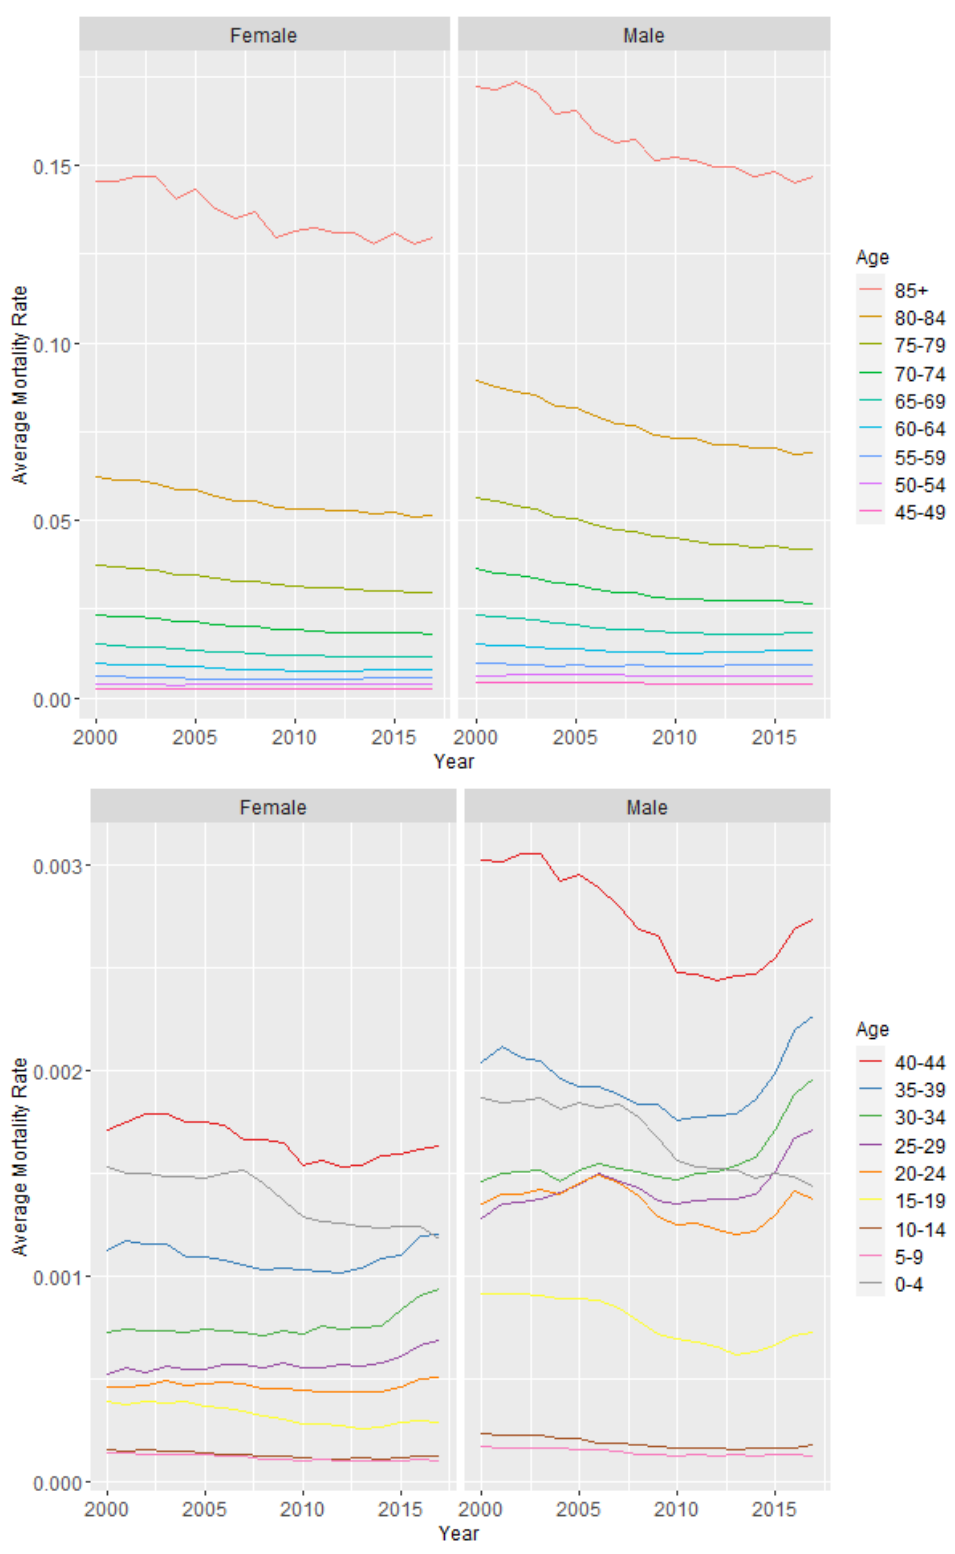
Figure 3. Average mortality rate by sex, age group, and year. The plots on the left show mortality rates for females while the plots on the right show mortality rates for males. The upper plots show mortality rates for age groups 10–18 while the lower plots show mortality rates for age groups 1–9. The plots are divided for legibility